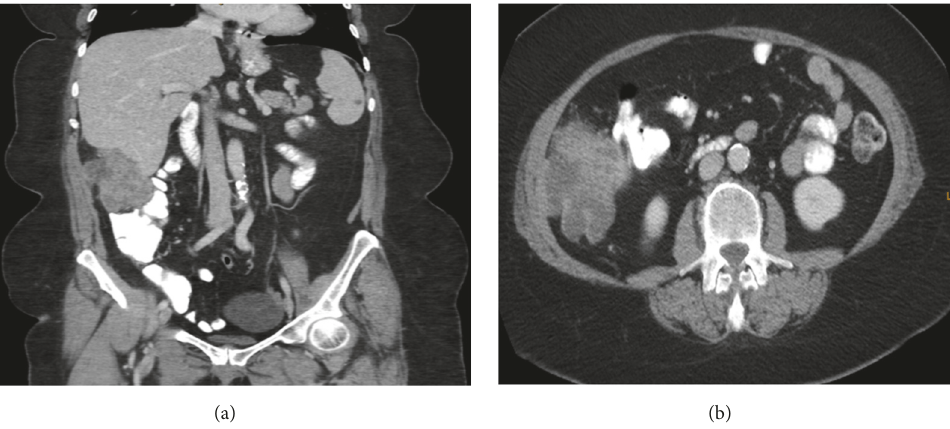
Figure 1: (a, b) CT abdomen/pelvis